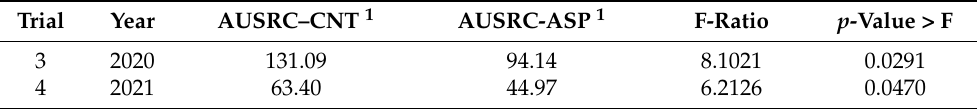
Figure 1. Dynamics of spore release and mean temperature, daily wetness duration and rainfall in trials 3 and 4 performed on 2020 and 2021, respectively. Table 3. Comparison of area under the spore release curve (AUSRC) obtained in the control plots and the aspiration plots in 2020 and 2021 by Student’s t test .